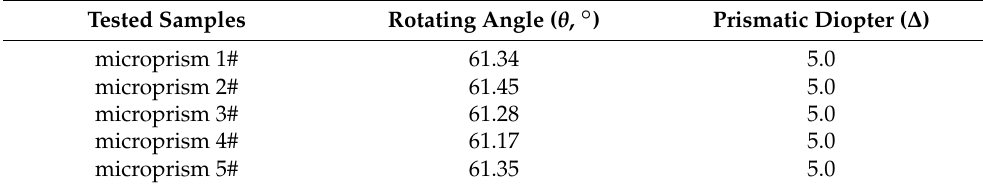
Table 3. Measured prismatic diopters of five fabricated microprisms.